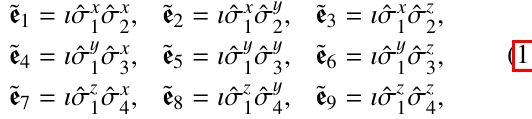
Figure 1: Ternary Υ